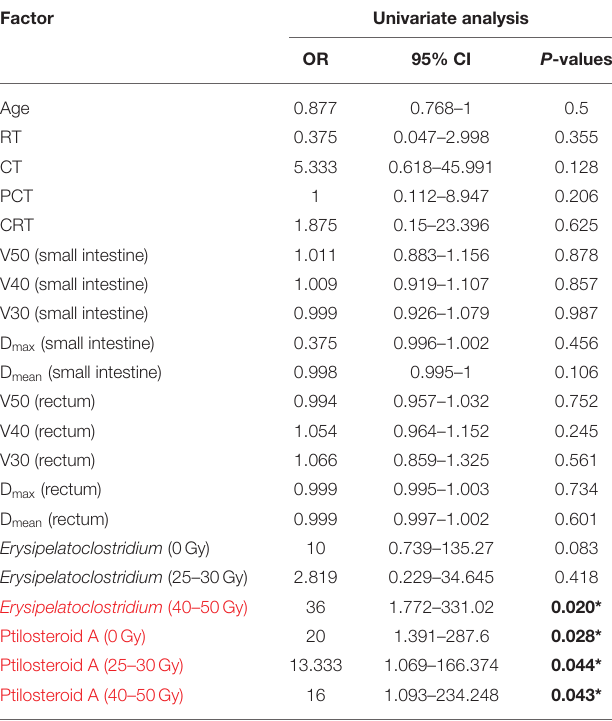
TABLE 4 | Univariate analysis of predictive factors associated with grade 2